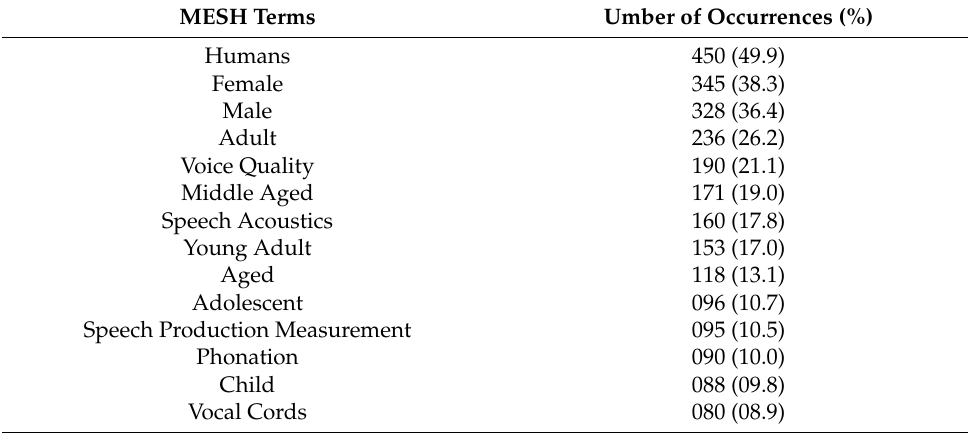
Table 2. Most frequently used MESH terms.